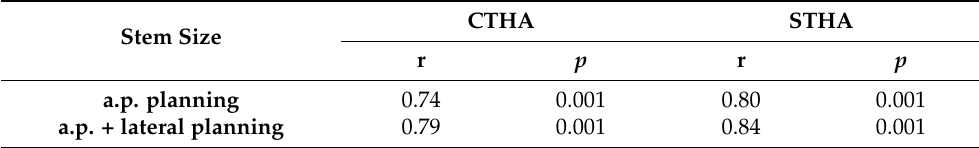
Table 6. Spearman’s coefficient a value for the correlation between the templated and the implanted stem